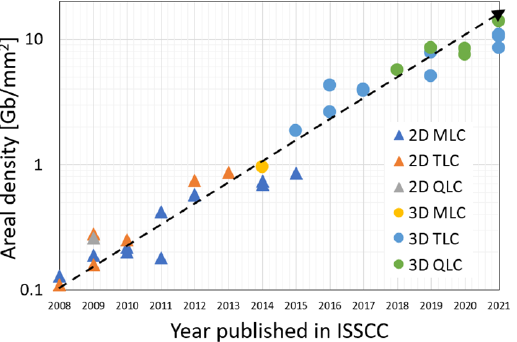
Figure 1. Areal density trend of NAND flash chip presented in ISSCC conferences since 2008 [2–31]. Adapted with permission from ref. [34], Copyright 2020 IEEE. 2. 3D NAND Architecture and Operations Figure 2 shows the 3D NAND cell array architectures. The strings are placed in the vertical direction. Word lines (WLs) have a plate-like shape and are stacked vertically for 3D cell stacking. There are multiple select gates at the drain side (SGDs) in a block. The channel of the NAND string has a cylinder shape.